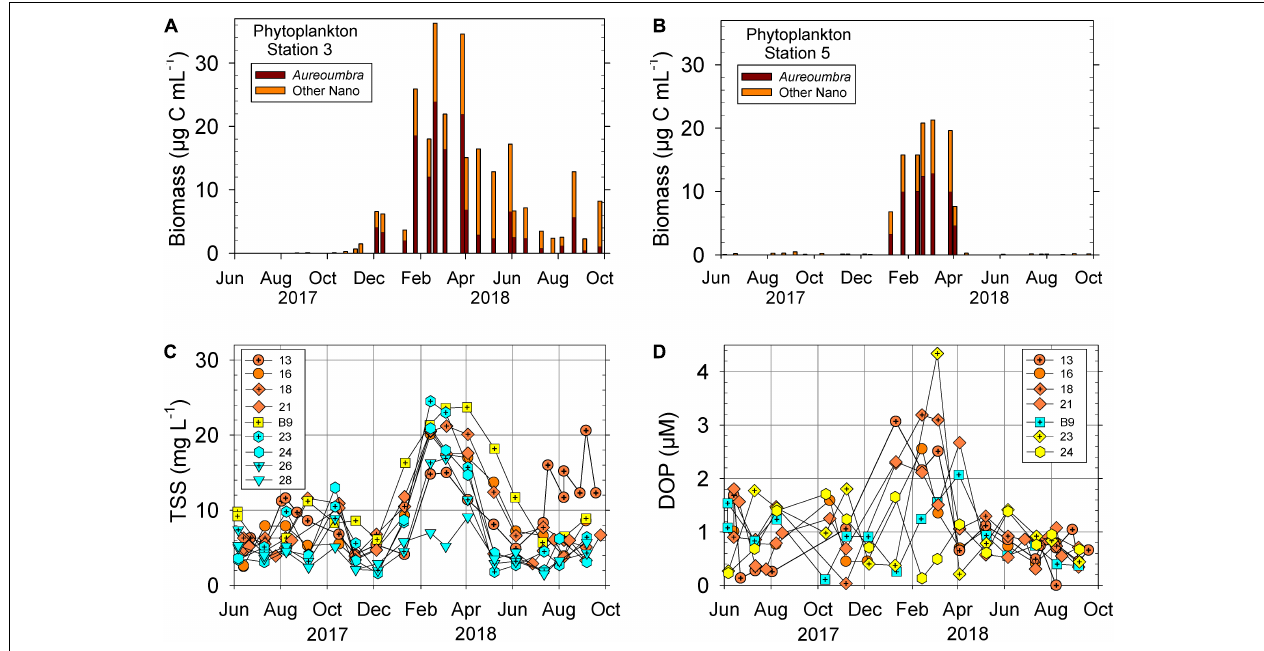
FIGURE 7 | Phytoplankton biomass for Aureoumbra lagunensis and other nanoeukaryotes at plankton stations (A) 3 and (B) 5 ( Figure 1 ). (C) Total suspended solids (TSS) and (D) dissolved organic phosphorus (DOP) for stations in the Indian River Lagoon (IRL) and Banana River Lagoon (BRL). Data for plankton from Phlips et al. (2021) and physicochemical parameters from St. Johns River Water Management District [SJRWMD] (2020b). Markers for (C,D) are color coded as orange (North IRL), yellow (BRL) and blue (Central IRL).